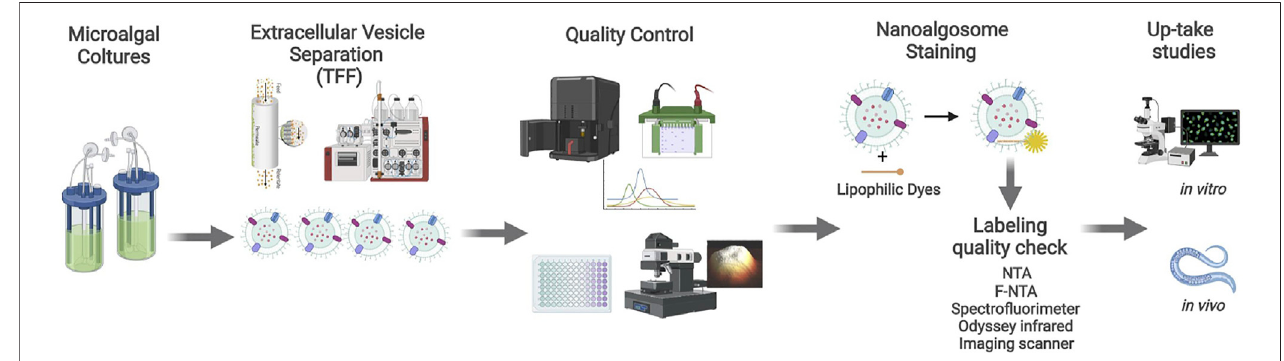
FIGURE 1 | Nanoalgosome production work fl ow. Starting from the T. chuii culture medium, nanoalgosomes are separated by TFF and checked by quality control procedures. Downstream analyses include the staining of nanoalgosomes and in vitro and in vivo uptake studies . Created also with the support of BioRender.com.